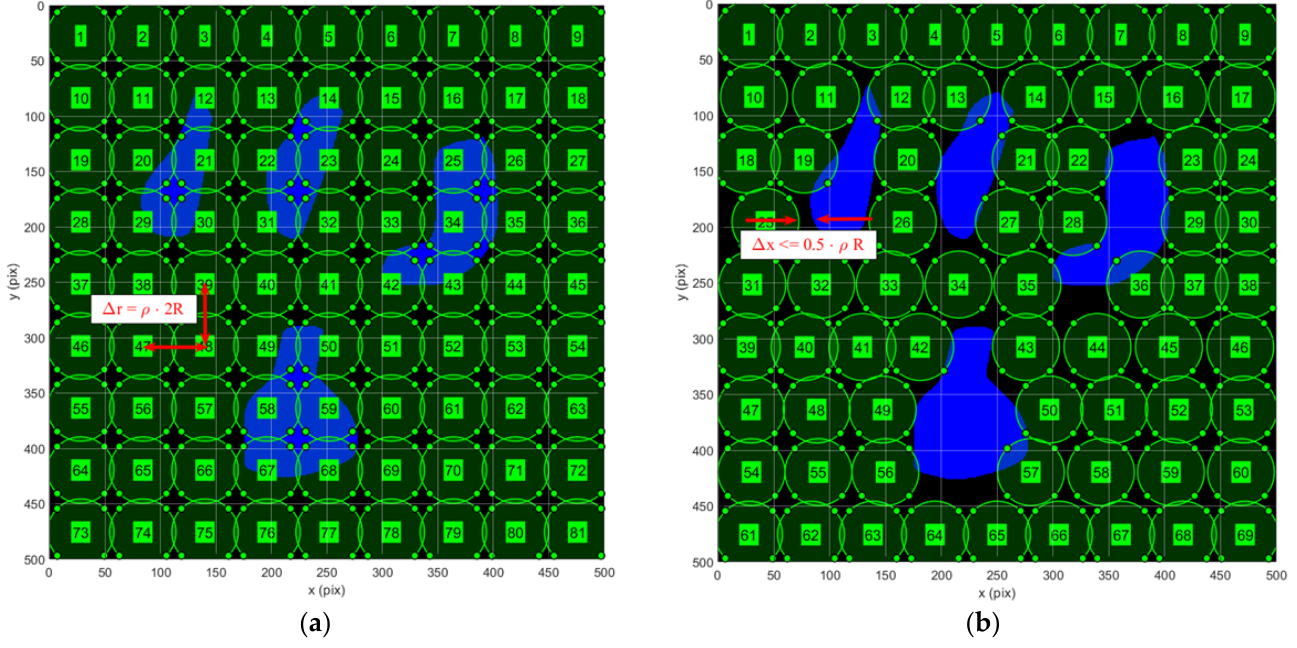
Figure 3. ( a ) Non-distorted grid of the sensor fields of view. Δ𝑟 = 𝜌 ⋅ 2𝑅 is the distance between the nodes of the grid; ( b ) The distorted grid of the sensor fields of view. The minimal size along x axis of the noncovered part of the map is Δ𝑥 ≤ 0.5 ⋅ 𝜌𝑅 .